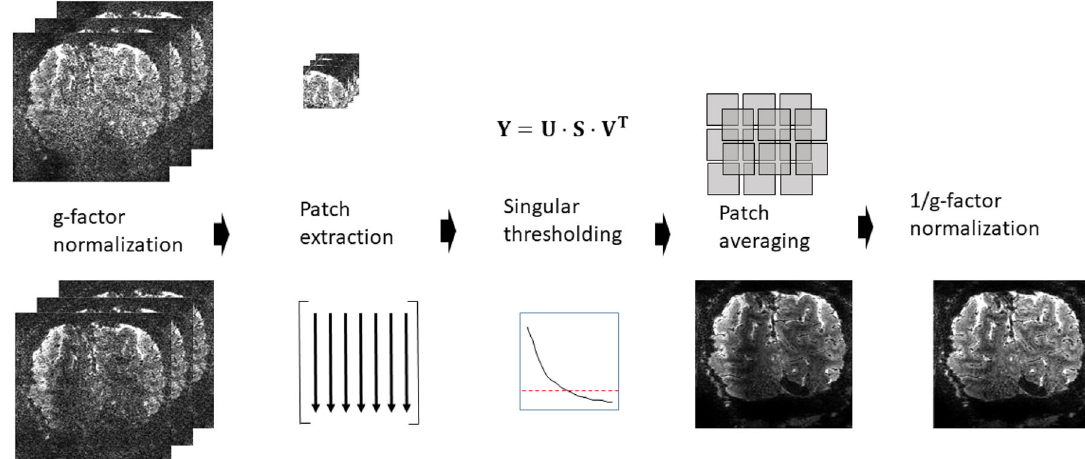
Fig. 7 Flowchart of the NORDIC algorithm for a series m ð r ; τ Þ . First, to ensure i.i.d. noise the series is normalized with the calculated g -factor kernels as m ð r ; τ Þ = g ð r Þ . From the normalized series, the Casorati matrix Y ¼ ½ y each patch. The low-rank estimate of Y is calculated as Y L ¼ U (cid:2) S λ series m LLR ð r ; τ Þ with patch averaging, the normalization with the calculated g -factor is reversed as m NORDIC ð r ; τ Þ ¼ m LLR ð r ; τ Þ (cid:2) g ð r Þ